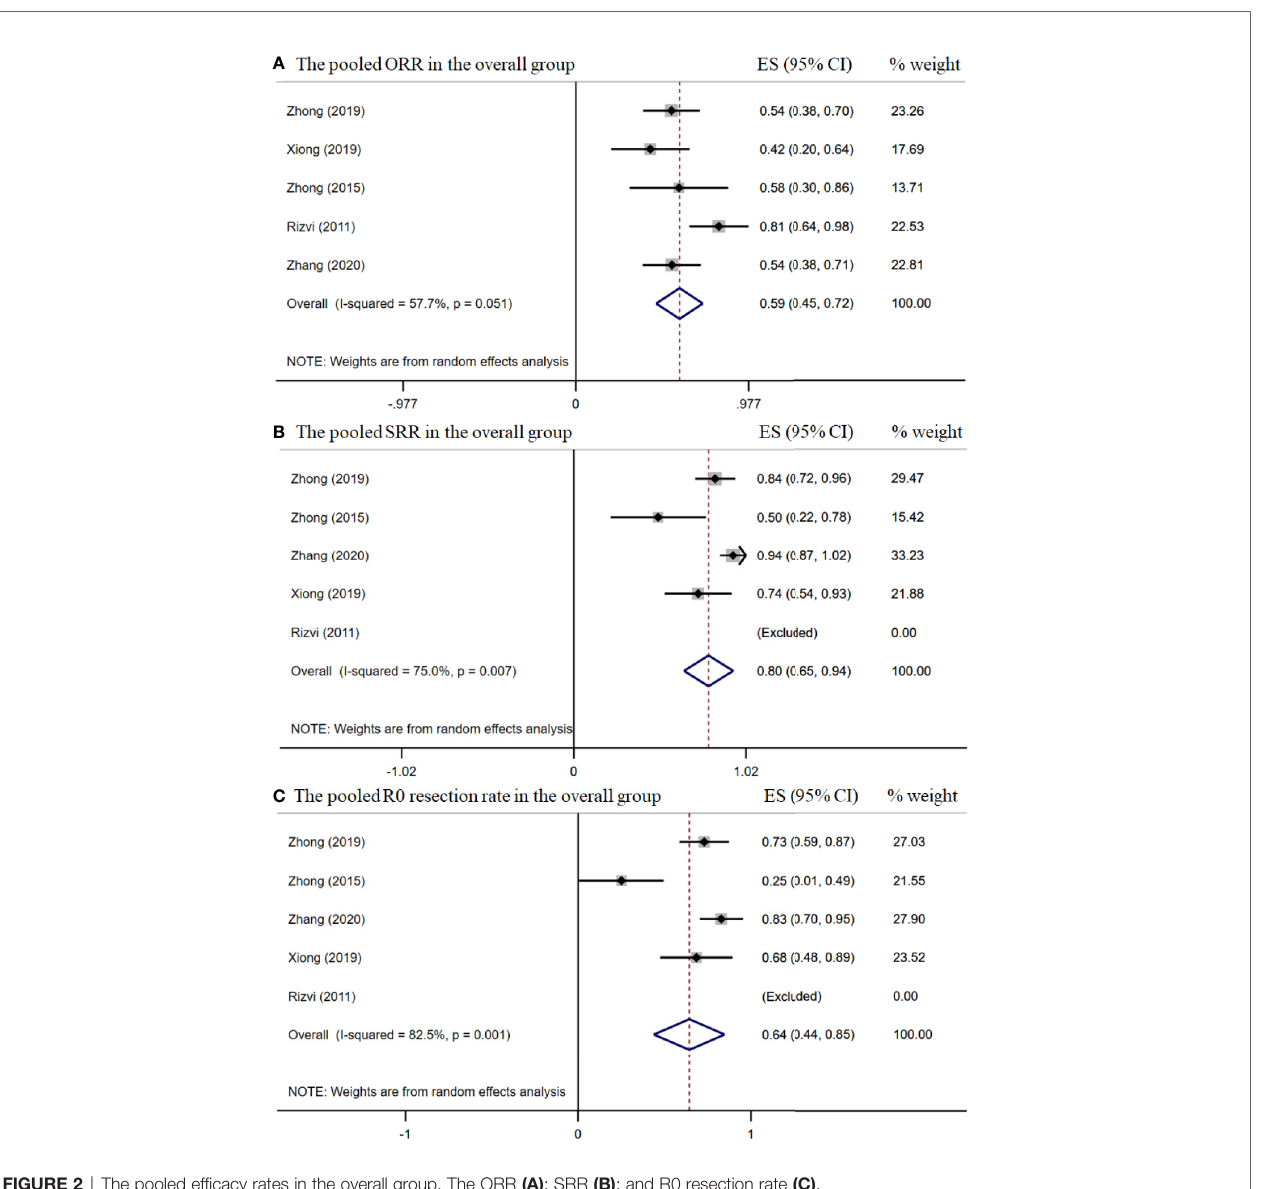
FIGURE 2 | The pooled ef fi cacy rates in the overall group. The ORR (A) ; SRR (B) ; and R0 resection rate (C)